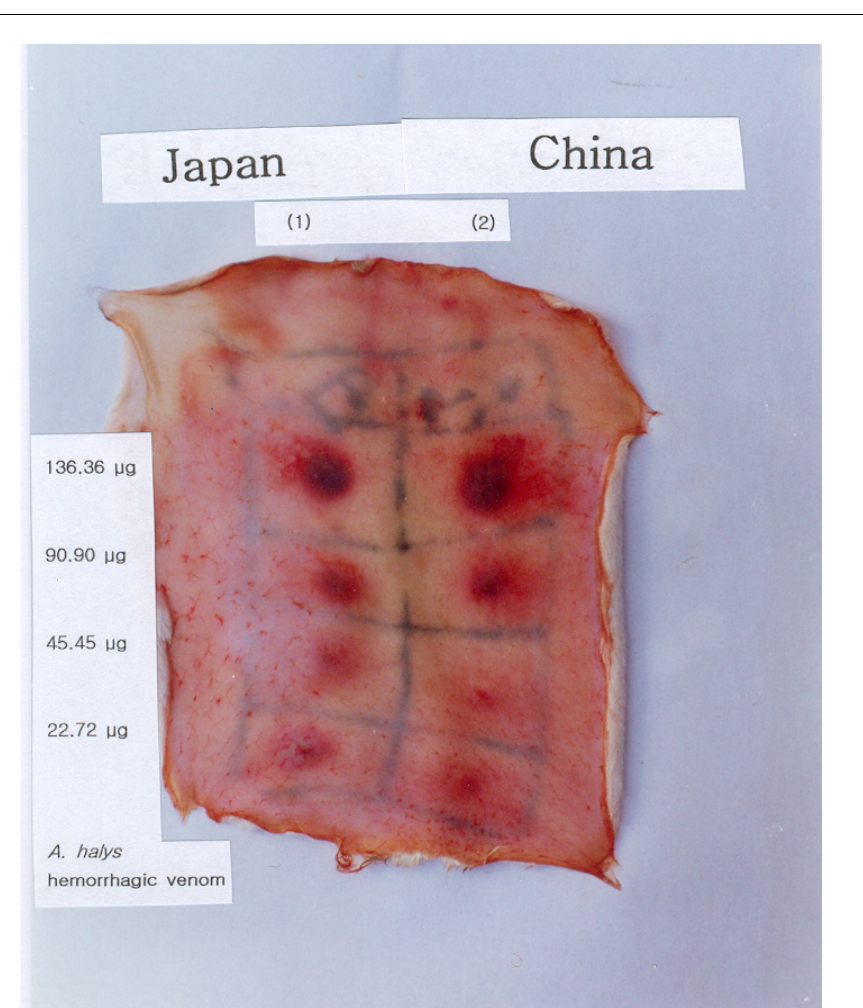
Figure 3: Hemorrhagic spots on the skin of rabbits intracutaneously injected with one unit of antihemorrhagic activity of Agkistrodon halys antivenom from Japan (1) and Jiangzhe Agkistrodon halys antivenom from China (2) against the test dose of Agkistrodon halys venom for determination of their antihemorrhagic